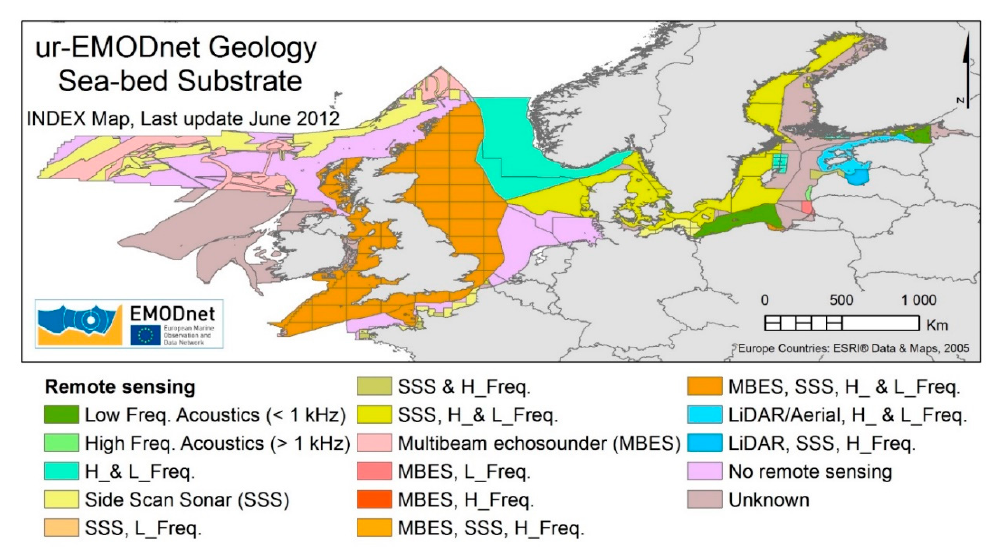
Figure 2. Different seabed survey methods and their combinations used to create national and regional substrate maps, including low-frequency acoustics (L_Freq < 1 kHz), high-frequency acoustics (H_Freq > 1 kHz), side-scan sonar (SSS), multibeam echosounder (MBES), LiDAR and no remote sensing (e.g., sample based).